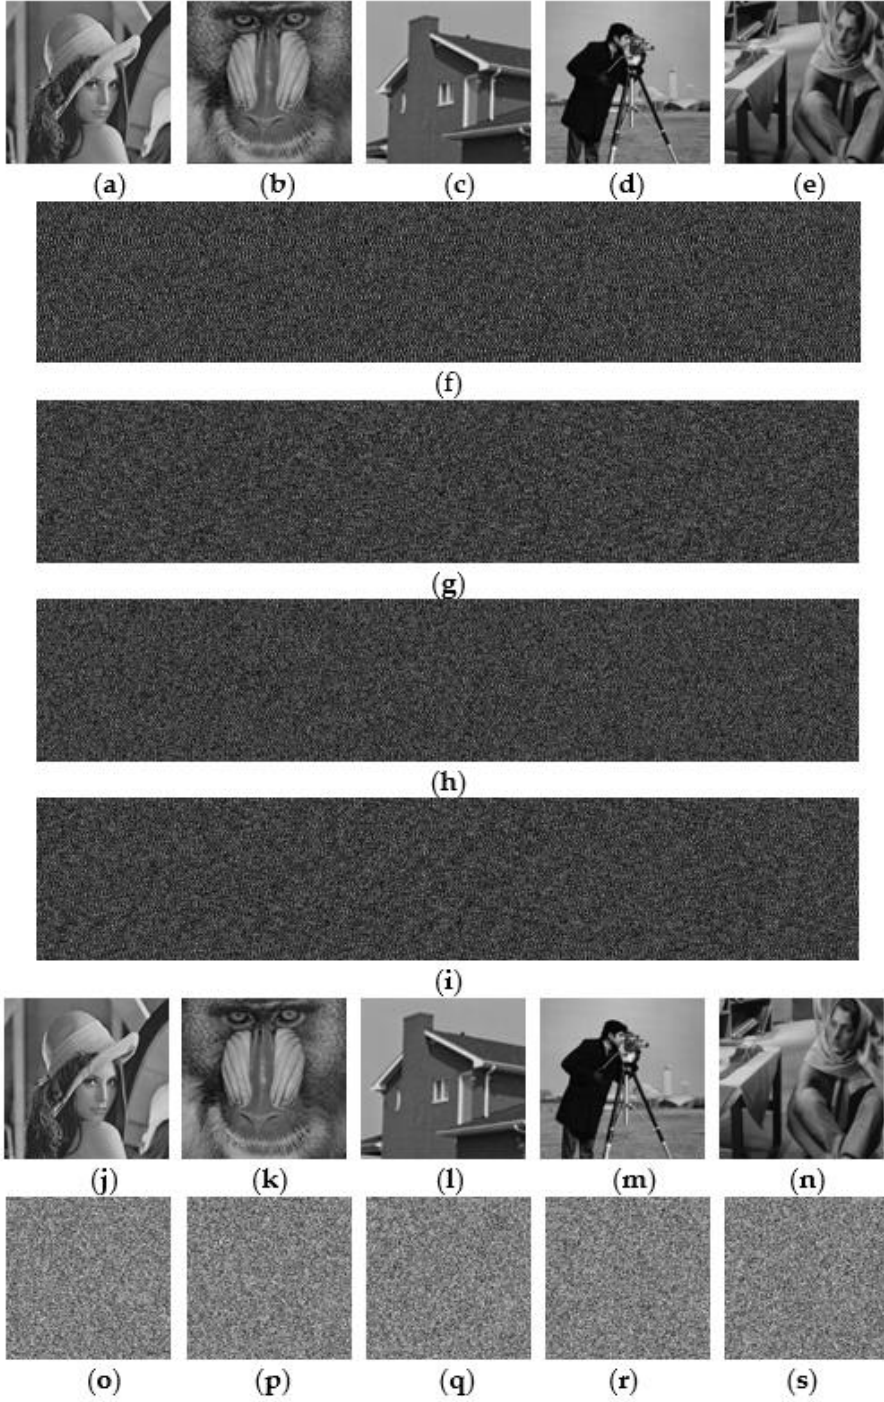
Figure 8. Results of the first proposed (3, 4, 5) SRM method. ( a – e ): 5 secret images with size 256 × 256; ( f – i ): 4 shared images with size 256 × 1280; ( j – n ): 5 recovered secret images from ( f – h ); ( o – s ): 5 recovered secret images from ( f , g ).